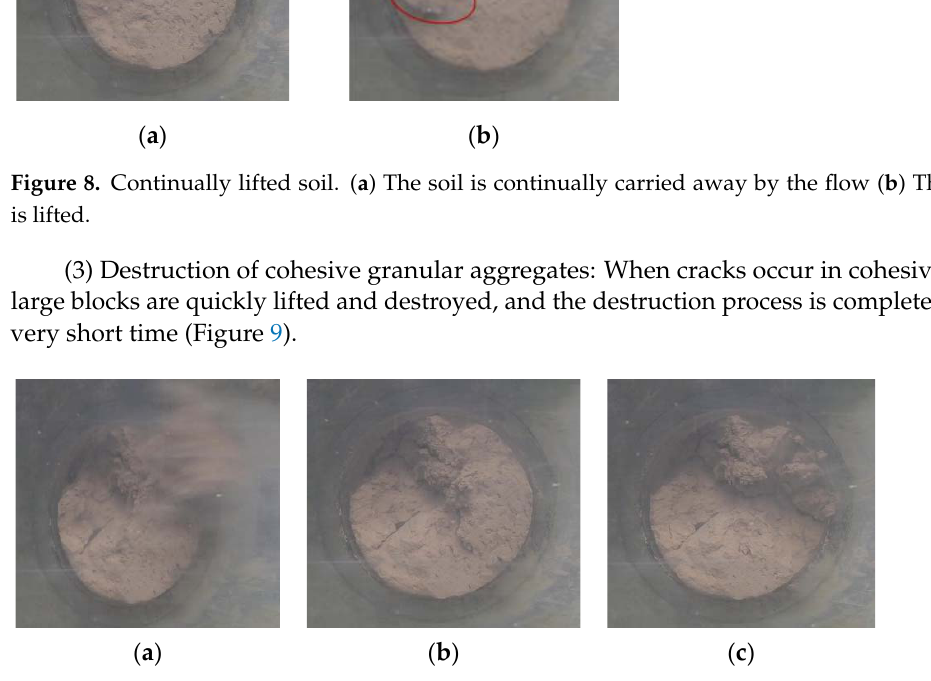
Figure 9. A large sample of soil is lifted in an instant, and the sample is destroyed. ( a ) The cohesive soil block is lifted momentarily ( b ) The cohesive soil block are lifted ( c ) The failure of cohesive soil block is completed.